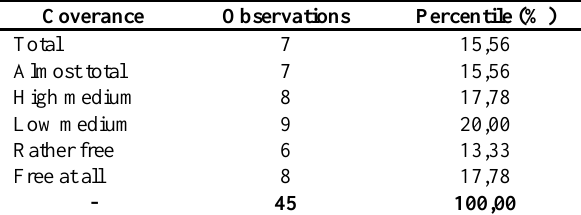
Table 1. Cloud coverage index and its related image amount.